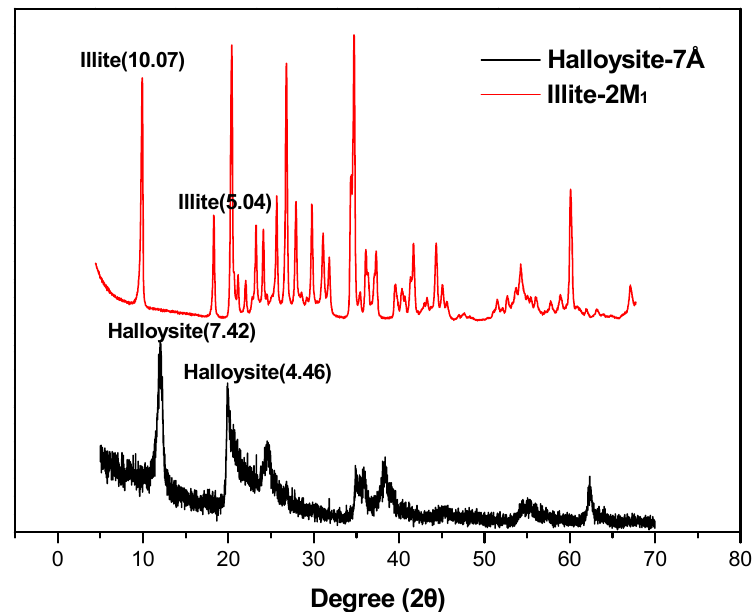
Figure 1. XRD patterns for halloysite and illite.